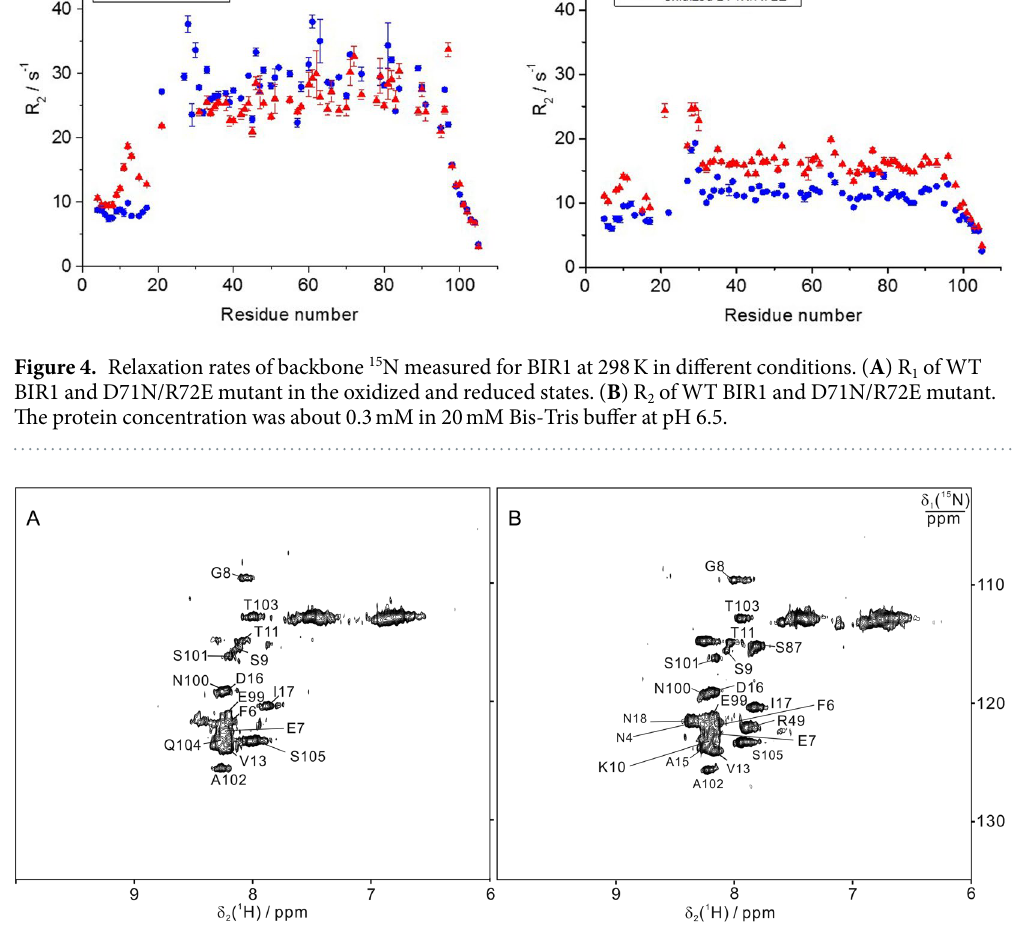
Figure 5. In cell 15 N-HSQC spectra recorded in oocytes via microinjection at 298 K. ( A ) WT BIR1; ( B ) D71N/ R72E